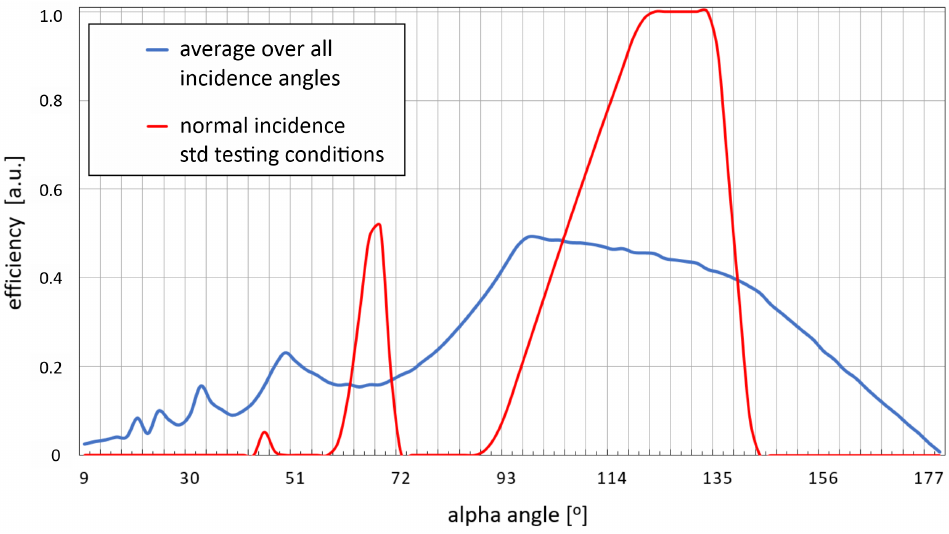
Figure 5. Ray tracing simulation